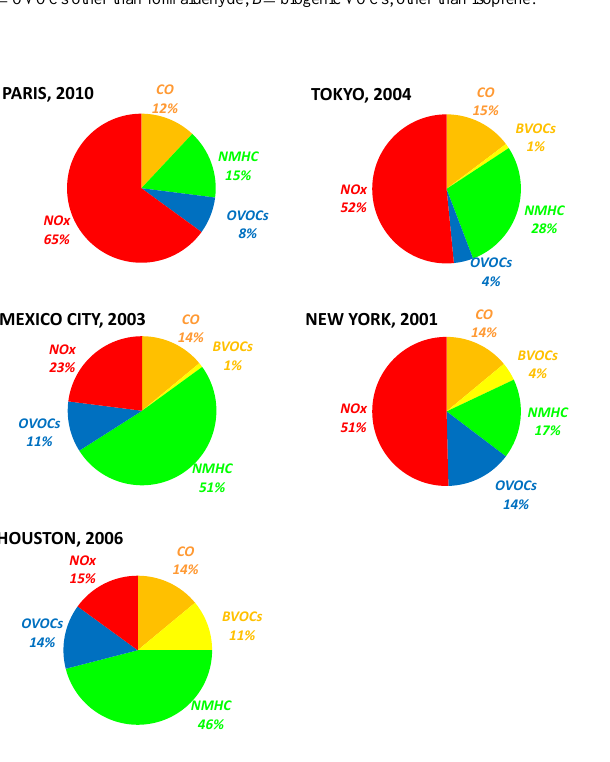
Fig. 14. Contribution of different atmospheric compounds to OH reactivity in Paris (winter 2010), Tokyo (winter 2004), Mexico City (spring 2003), New York (summer 2001) and Houston (autumn